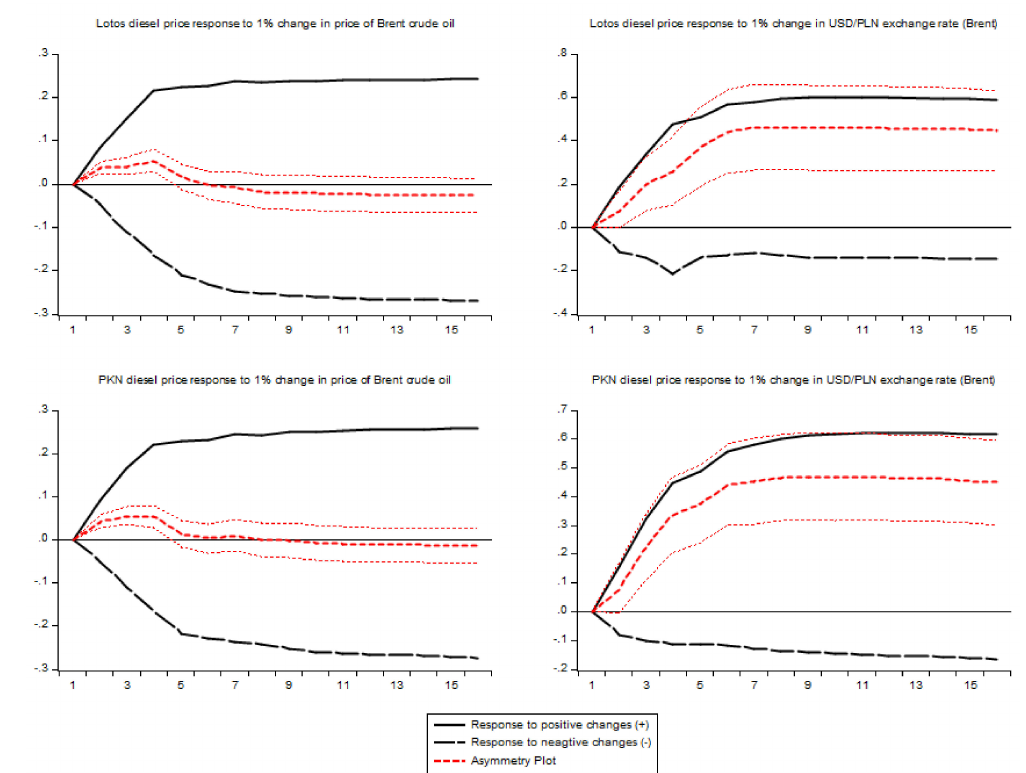
Figure 7. Dynamic multipliers—whole sample, wholesale diesel, and Brent crude.